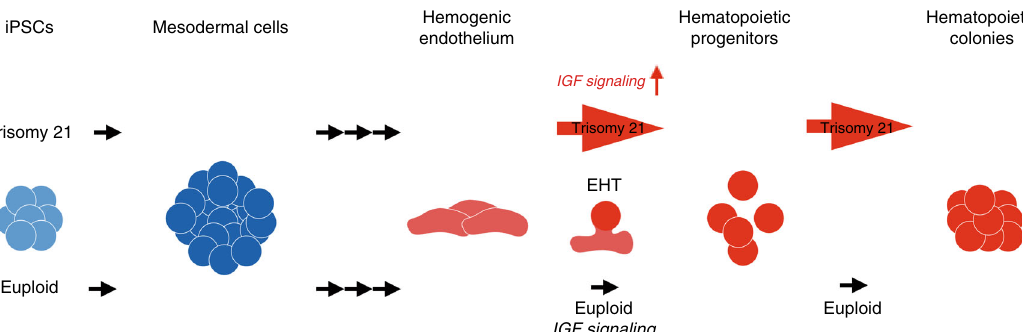
Fig. 7 Schematic of how trisomy 21 affects distinct steps in hematopoiesis. Trisomy 21 initially increases the production of hematopoietic progenitor cells as they emerge from the endothelial-to-hematopoietic transition. A likely enhanced EHT process is accompanied by increased IGF signaling. Trisomy 21 also increases the colony-forming potential of these hematopoietic progenitor